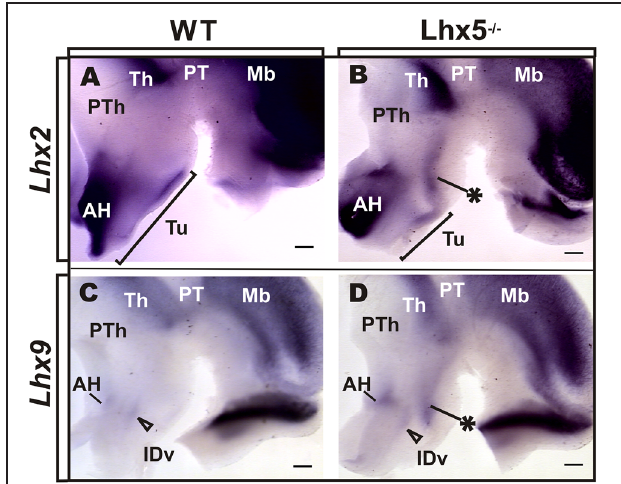
FIGURE 5 | Lxh2 and Lhx9 misexpression in the Lhx5 − / − posterior hypothalamus. Whole-mount ISH for Lhx2 (A,B) and Lhx9 (C,D) in control and Lhx5 mutant E12.5 embryos (anterior is to the left), showing ectopic expression of both markers in the posterior hypothalamus of Lhx5 mutants (asterisks in B,D ). (A,B) The Lhx2 -expressing region in the AH was present in both conditions, but the tuberal expression domain appeared shortened along the anterior–posterior axis (brackets in A,B ). (C,D) Lhx9 is expressed at low levels in the anterior hypothalamus in both controls and Lhx5 mutants, in a region that might correspond to the IDv domain (empty arrowheads). Note that expression of both genes in the Th seems unaltered in Lhx5 mutants. Abbreviations: AH, anterior hypothalamus; Th, thalamus; IDv, ventral intrahypothalamic diagonal; Mb, midbrain; PT, pretectum; PTh, prethalamus; Tu, tuberal. Scale bar: 200 µ